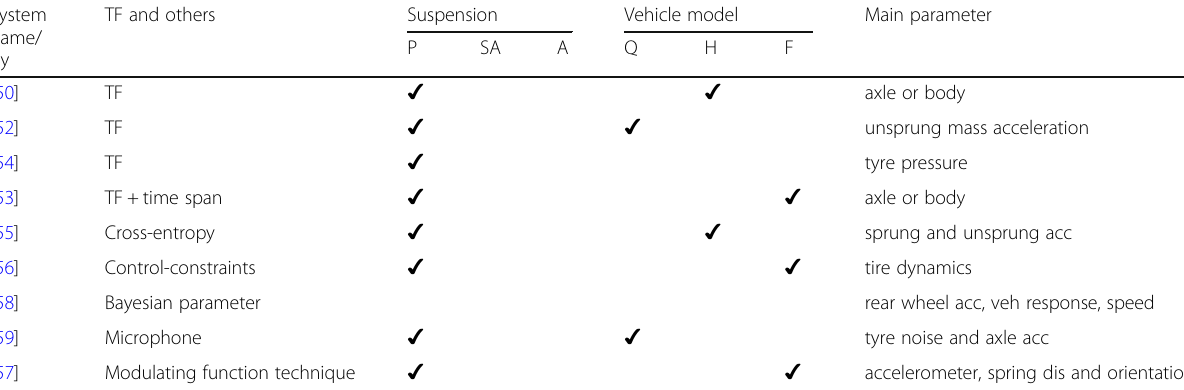
Table 3 Summary of TF and other methods for road profile reconstruction function System name/